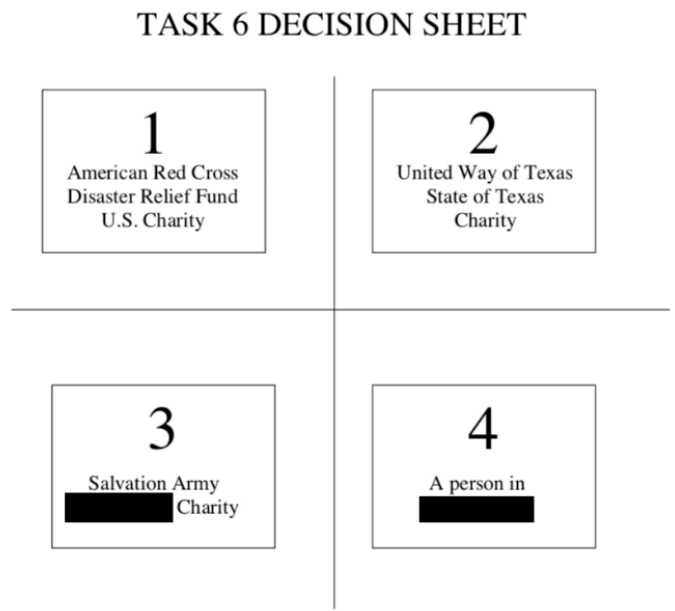
Figure 2. Decision sheets used by subjects when deciding which charity from Task 5 to choose as the sole recipient in the selected dictator game. References to towns are blacked out.